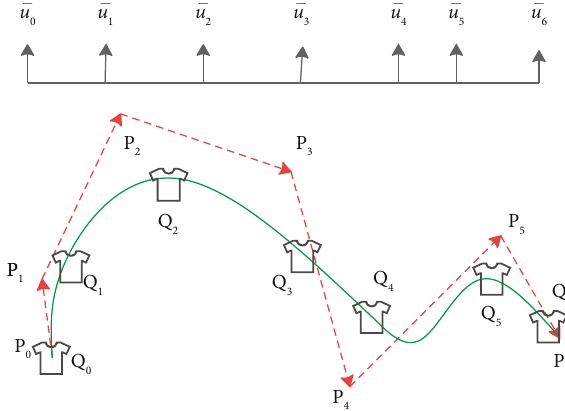
Figure 1: Control point, shape point, and node vector of cubic